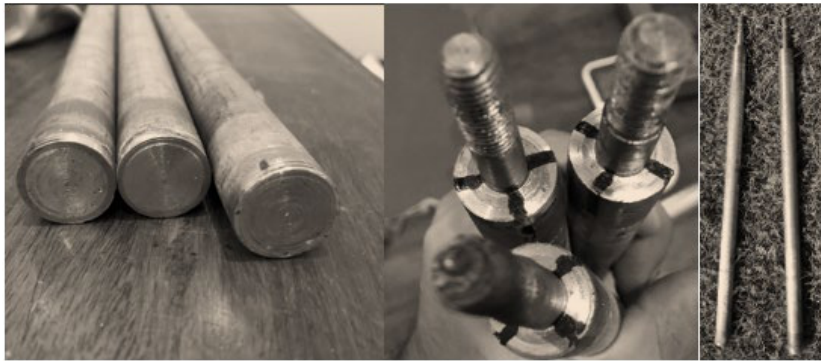
Figure 3. Galvanized iron pipes used as a pile in model piled raft.